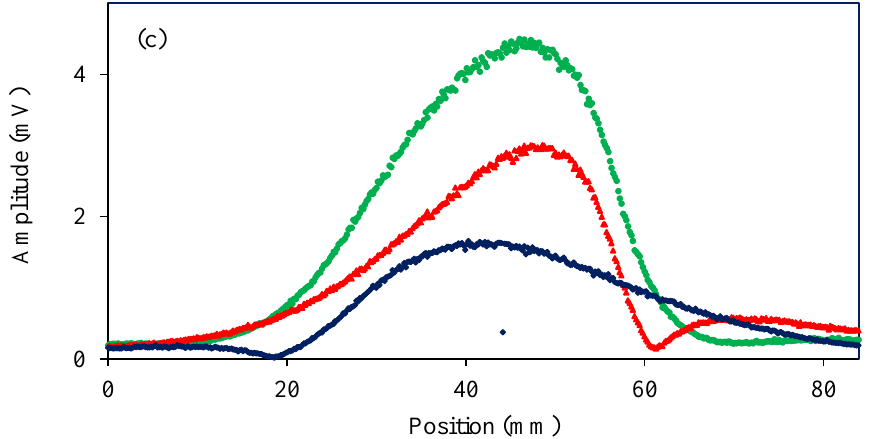
Figure 11. Signal amplitude measured across a 1D scan over the middle of a 40 × 40mm 2 plate which is tilted at 30 ◦ , where the differences in the two coils lift-offs are ( a ), + 5mm, ( b ) 0mm, and ( c ) − 5mm. The coil on same/opposite side as sensor is shown with red triangles/ blue diamonds and the two coil configuration is given by the green